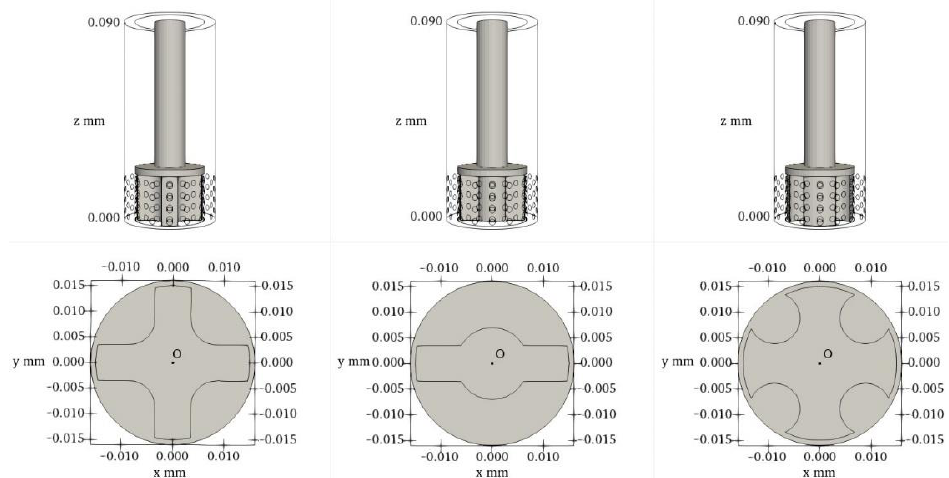
Figure 1. Rotor designs used in this study. The feature edges of the stator are in the top row of figures. The origin O denotes the coordinate (0, 0, 0). The bottom of the mixer is at z = 0 mm, with the z axis coincident with the axis of the rotor.